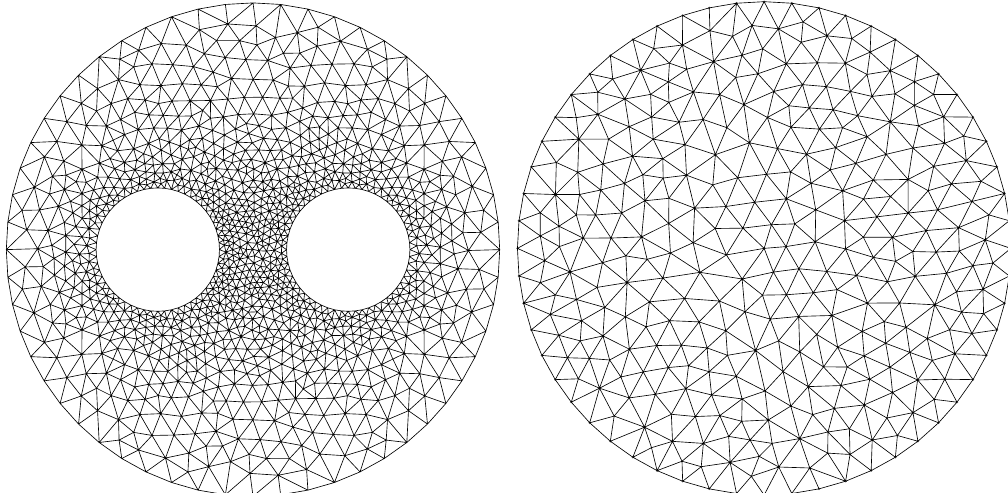
Figure 2. Delaunay mesh for the inner ( left ) and outer domain ( right ) with 1194 and 337 mesh points.